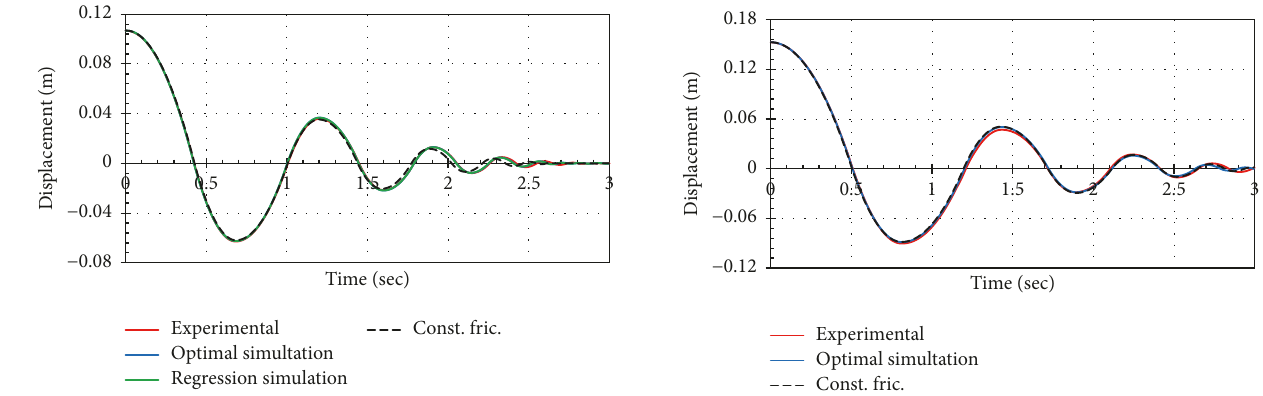
Figure 17: Simulation time history of displacement for the friction functionofmeasuringdisplacementandindividualbestfitandover- all best fitting function (WD40 sprayed with initial displacement of 152.56 mm).